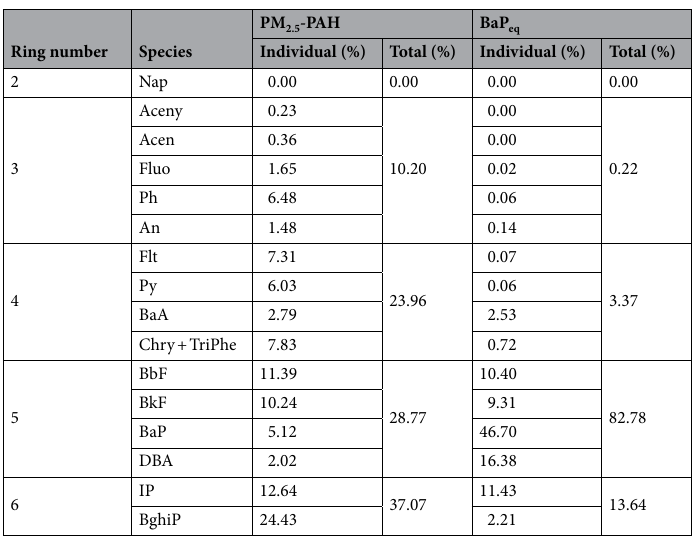
Table 2. Contributions of 16 PAHs with different ring numbers to the total PM 2.5 -associated PAH and BaP eq concentrations observed at different elevations during the sampling periods.